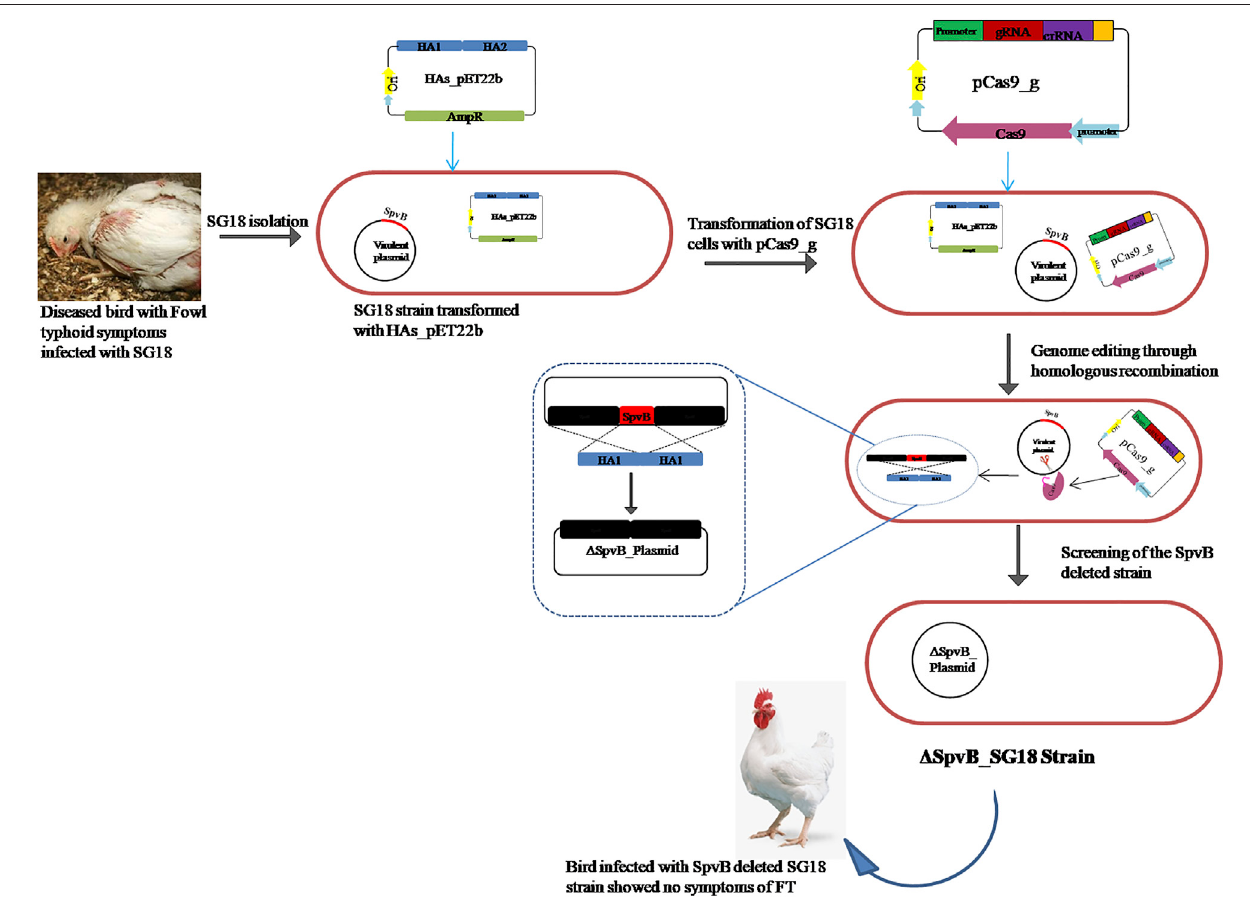
FIGURE1| DiagrammaticrepresentationofSpvBgenedeletionfrom S.gallinarum largevirulentplasmidthroughengineeredCRISPR/Cas9mediatedhomologous recombination.